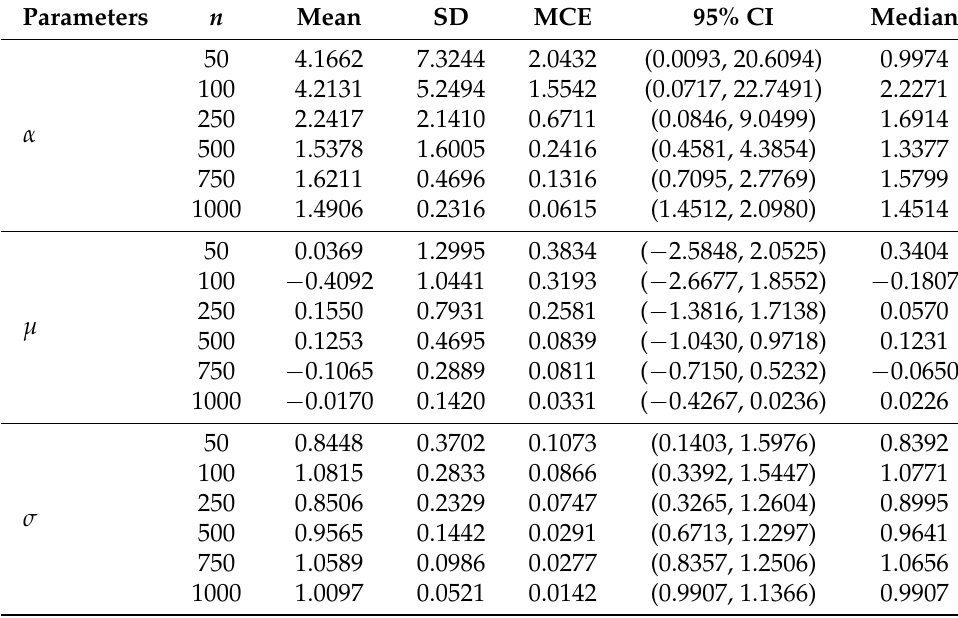
Table 6. Posterior summary results for ( α = 1.5, µ = 0, σ = 1).